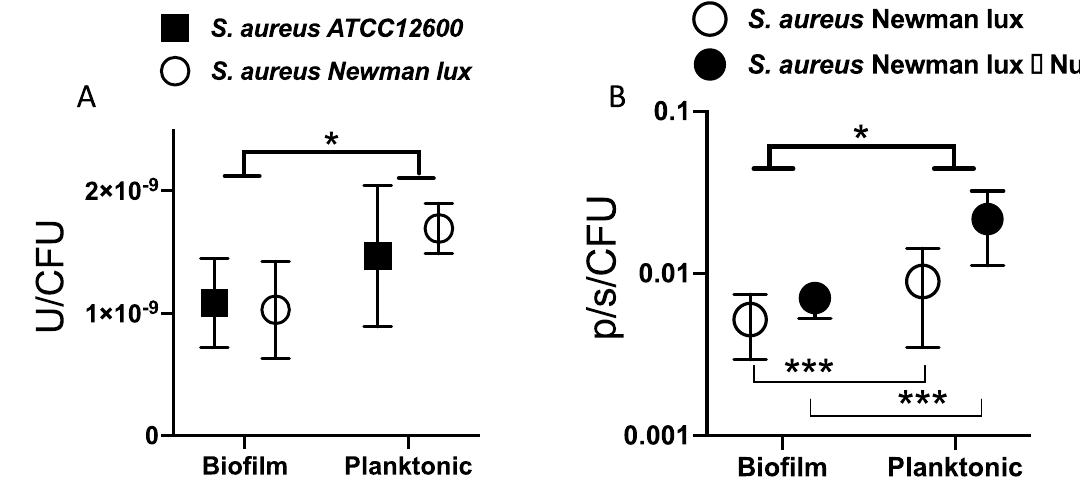
Figure 5. ( A ) Micrococcal nuclease activity (U), per colony forming unit (CFU) of S. aureus ATCC12600 and S. aureus Newman lux from planktonic and biofilm cultures. The type of culture (biofilm or planktonic) significantly affects the nuclease production. ( B ) Bacterial luminescence per CFU (photons/second/CFU) of S. aureus Newman lux and Δnuc1 mutant. The type of culture (biofilm or planktonic) significantly affects the luminescence for both strains individually. Data shown are averages of triplicate measurements, repeated on separate days. Statistical analysis was done using an ANOVA accounting for strain and type of culture. Error bars indicate standard deviations. Asterisks indicate significant differences (*p < 0.05; ***p <